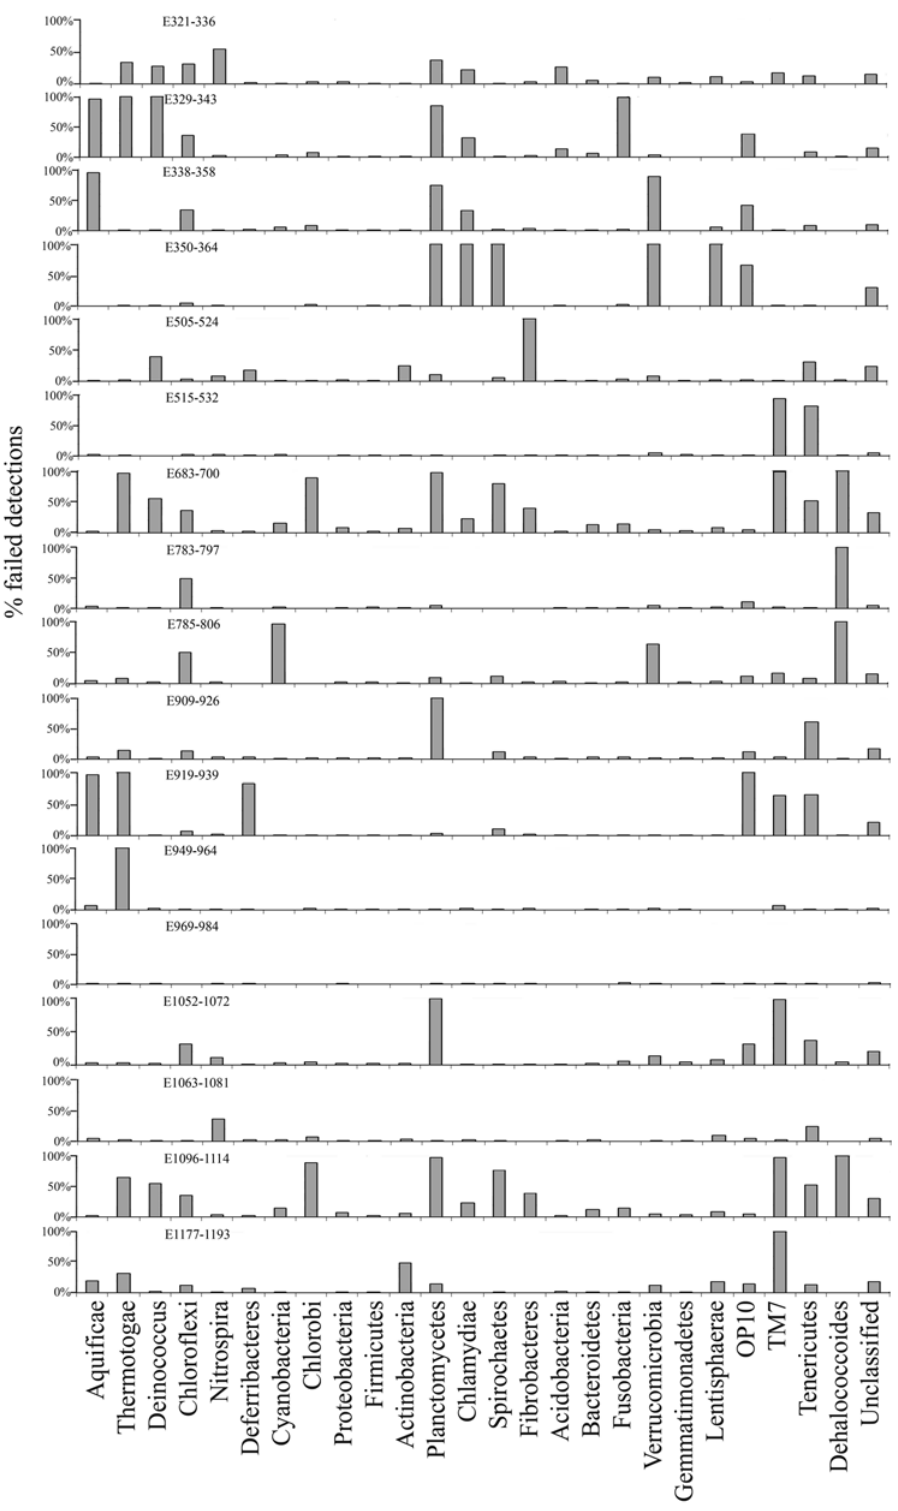
Figure 3. Phylum specificity of predicted primers for Eubacteria. Information on the primers is listed in Table 2. The primers were used to find their targets in 778 Aquificae, 325 Thermotogae, 550 Deinococcus, 1922 Chloroflexi, 651 Nitrospira, 245 Deferribacteres, 4655 Cyanobacteria, 195 Chlorobi, 91629 Proteobacteria, 94475 Firmicutes, 23266 Actinobacteria, 2274 Planctomycetes, 216 Chlamydiae, 2646 Spirochaetes, 202 Fibrobacteres, 4040 Acidobacteria, 33924 Bacteroidetes, 737 Fusobacteria, 2851 Verrucomicrobia, 441 Gemmatimonadetes, 108 Lentisphaerae, 114 OP10, 327 TM7, 1683 Tenericutes, 108 Dehalococcoides, and 6333 unclassified bacteria. The phyla with less than 100 sequences were ignored. The sequences without a target were classified into different phyla.